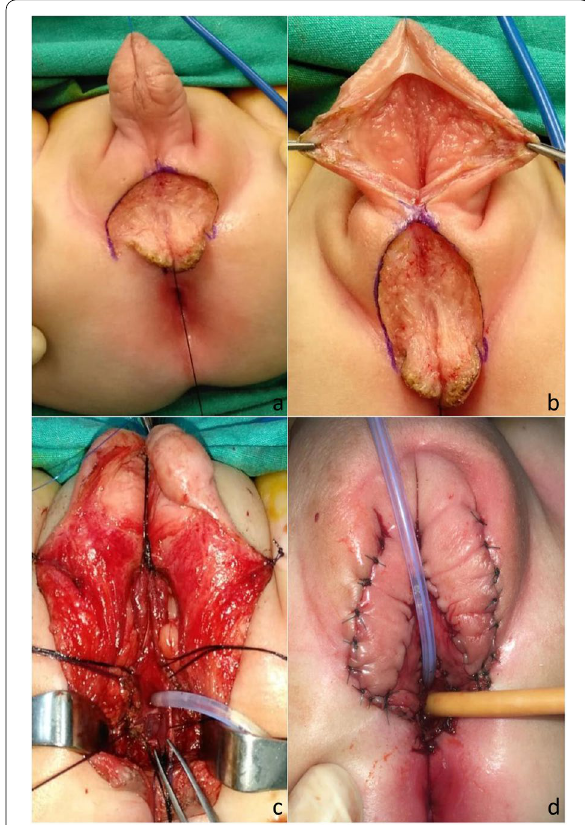
Fig. 2 Stages of total urogenital sinus mobilization (TUM)